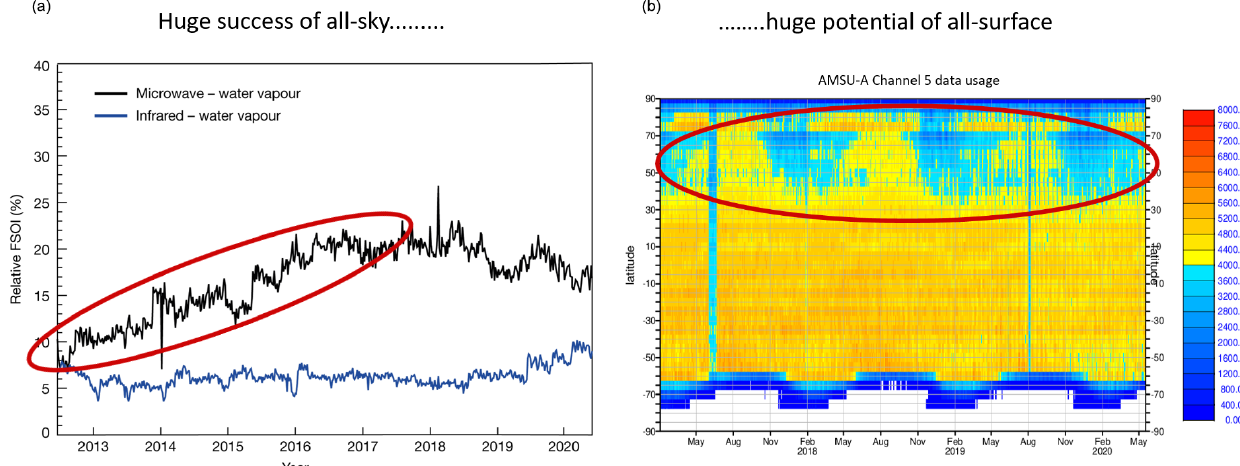
Figure 1. Better exploitation of satellite observations. The plot on the left shows the relative contribution of microwave water vapour channels to the forecast quality measured with a forecast sensitivity to observation impact (FSOI) technique. The contribution increased dramatically from little more than 5% to approaching 20% thanks to the development of solutions to use microwave data in all-sky conditions. The ECMWF strategy aims to expand this approach to cover all-surface conditions, a challenging but potentially very rewarding research area. The plot on the right shows the microwave radiometer AMSU-A lower tropospheric temperature (channel 5) assimilated daily at different latitudes. In the Northern Hemisphere, ECMWF manages to assimilate far fewer data at high latitudes in winter than in summer, due to the current limited ability to use the data over surfaces like snow and